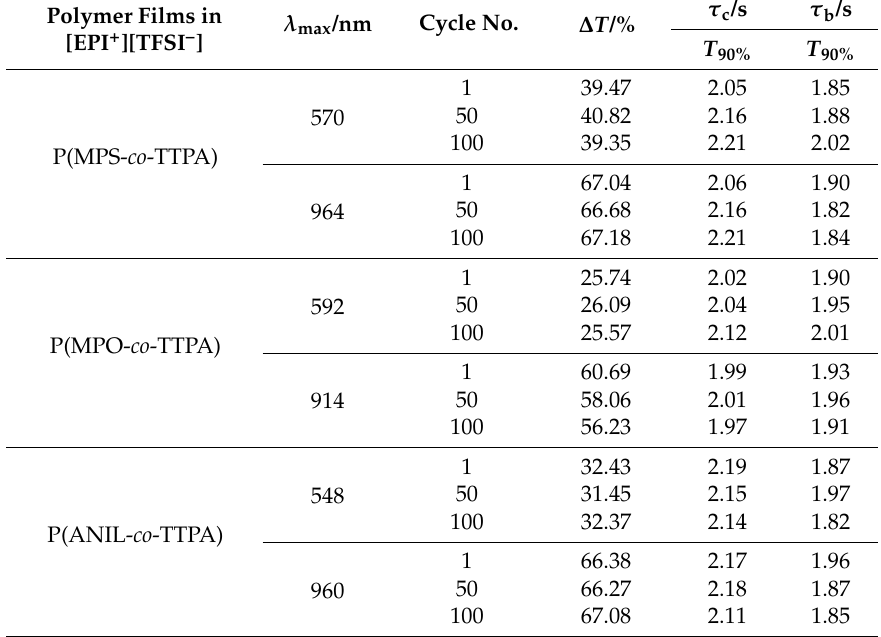
Table 3. Color–bleach switching properties of copolymer films in solution